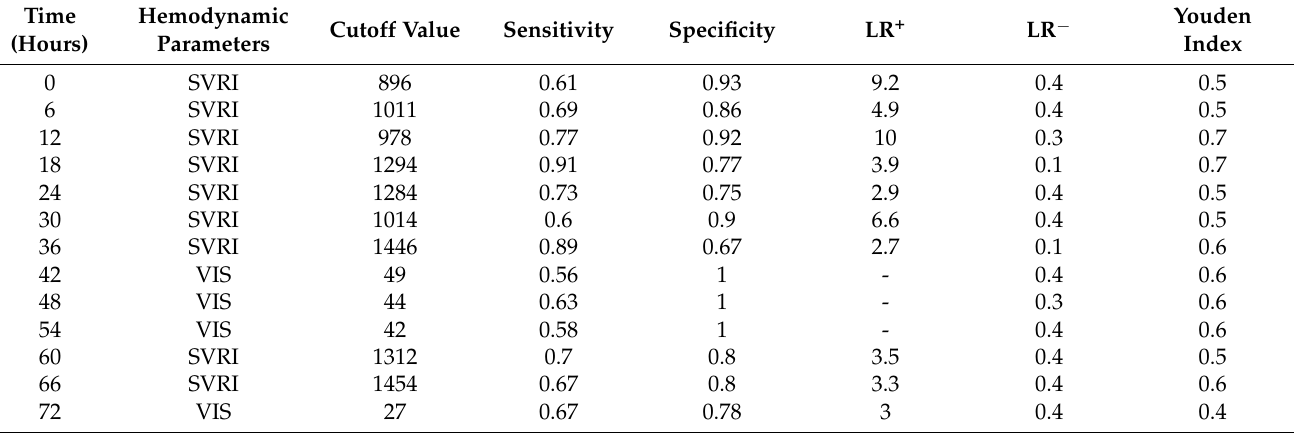
LR + , positive likelihood ratio; LR − , negative likelihood